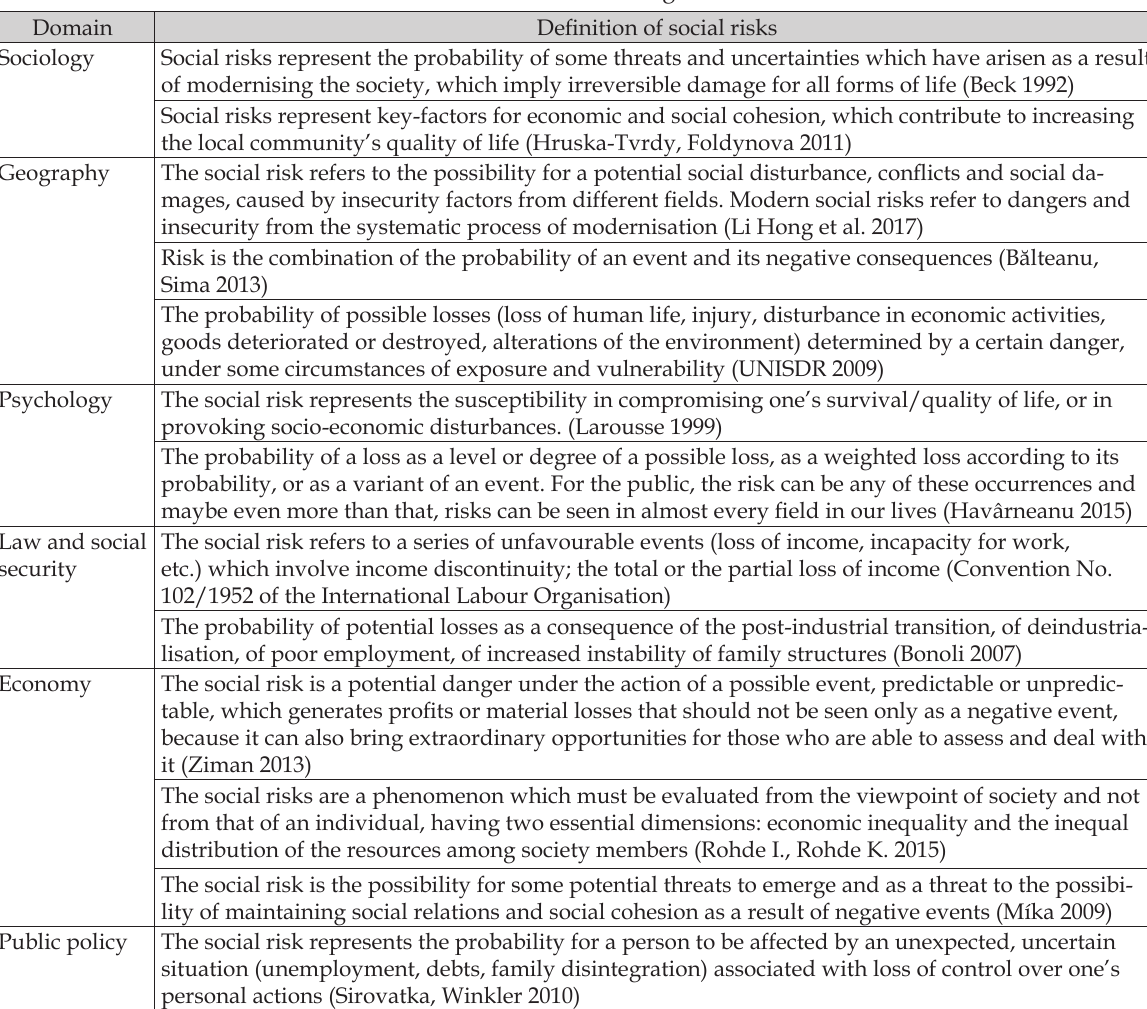
Table 1. Differences in defining social